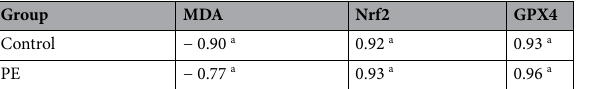
Table 7. Correlations of DJ-1 protein expression levels with the Nrf2/GPX4 signaling pathway protein expression levels and MDA concentrations in each group (r value). a Compared with the DJ-1 group P < 0.001.